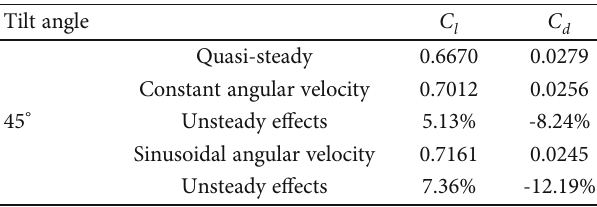
Figure 22: Unsteady lift and drag coe ffi cients for di ff erent conversion modes. Table 2: Quantitative comparisons of the aerodynamic coe ffi cients in 2D